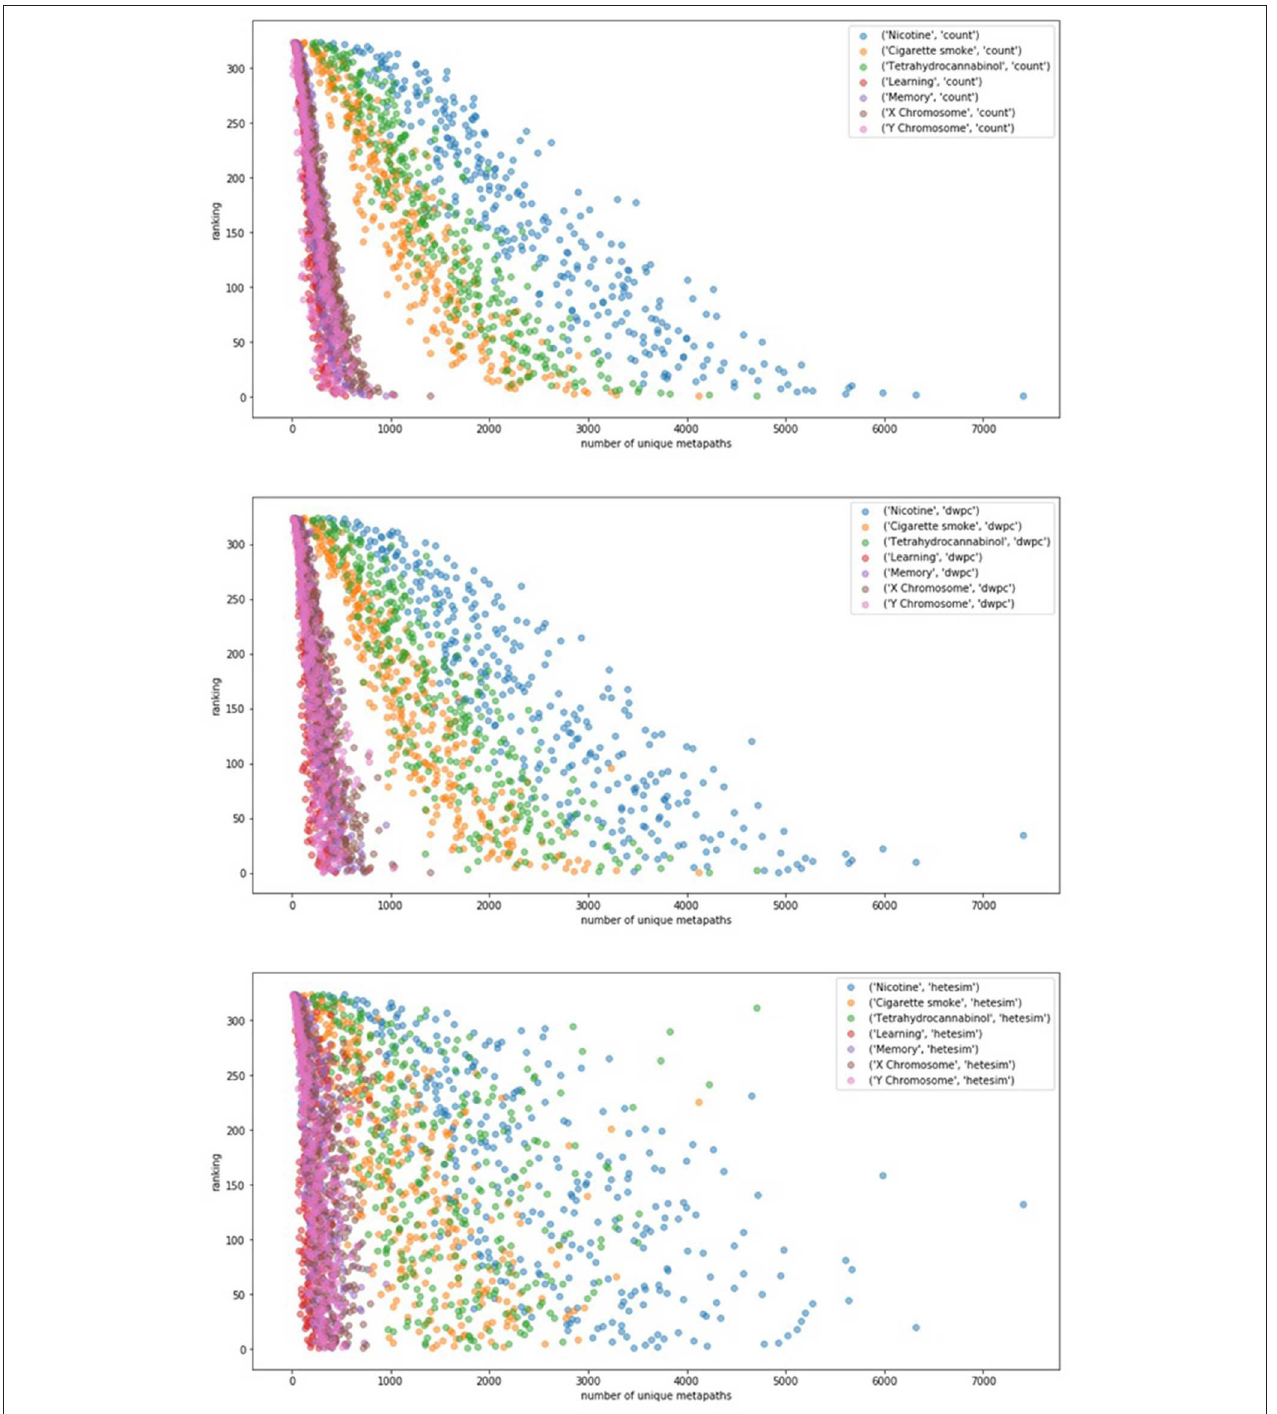
FIGURE 6 | The relationship between number of metapaths and final ranking outcome for different feature types (top: count, middle: DWPC, and bottom: HeteSim) is plotted. The figure contains 324 source nodes with respect to 7 targets using each of the three feature types. Number of metapaths predicts final count and DWPC-based ranking with fairly high accuracy, while the HeteSim rankings appear to be less influenced by the sheer number of non-zero metapath scores. Thus, the HeteSim is a superior ranking because its rankings are less biased toward metapath count.